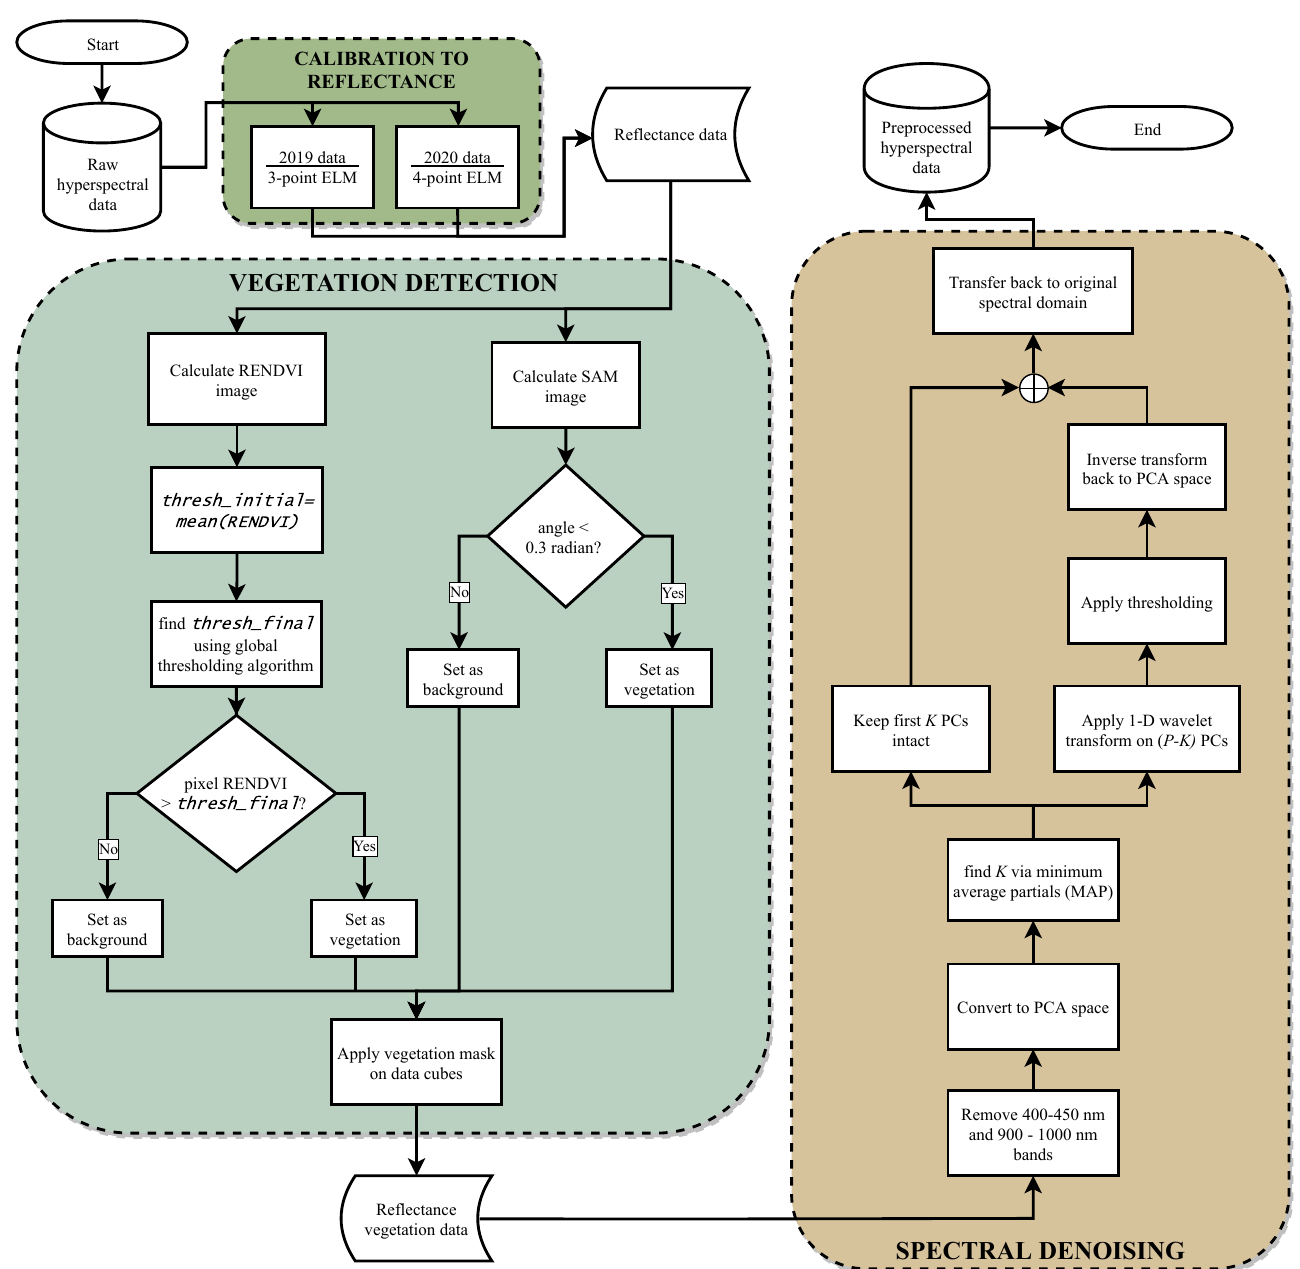
Figure 4. Flowchart of the steps employed for preprocessing raw hyperspectral data to evaluate snap bean yield components.